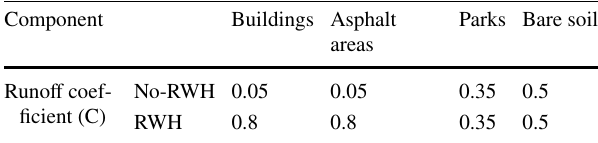
Table 1 Estimation of effective coefficient of runoff (Gabr et